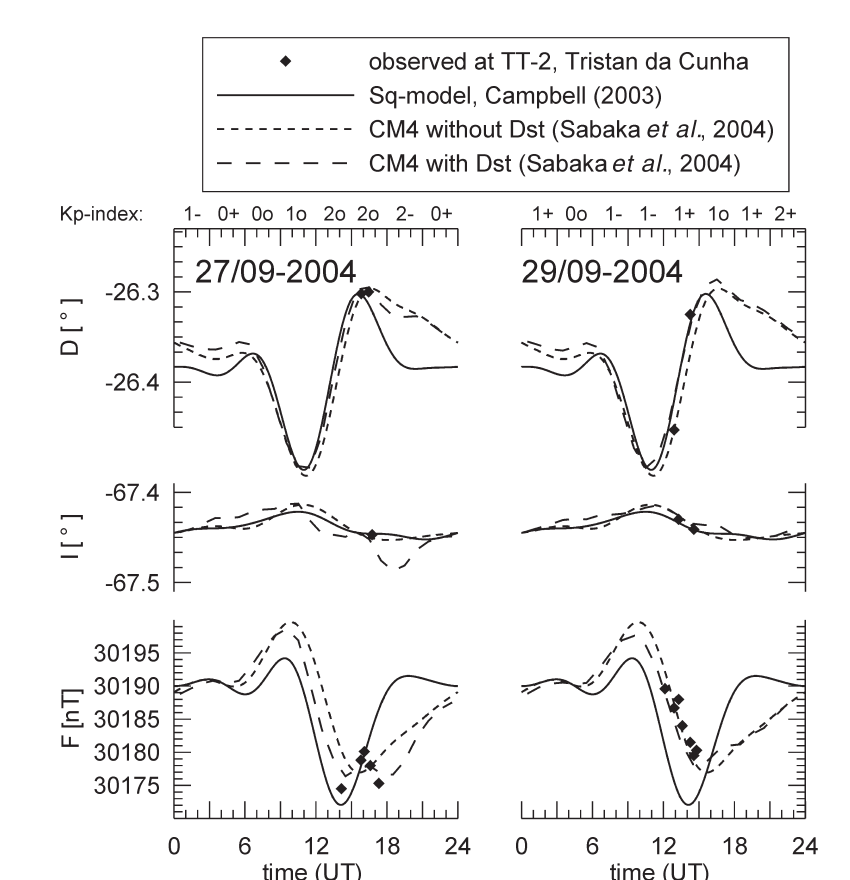
Fig. 2. Declination (D), inclination (I) and field strength (F) observations (diamonds) at TT-2, Tristan da Cun- ha, compared to three models (see text). Kp-values for the corresponding three-hour intervals are indicated at the top of the graph. Campbell’s (2003) Sq-model is shown as full lines, geomagnetic variations are calculated from CM4 with Dst (long dashed) and without Dst (short